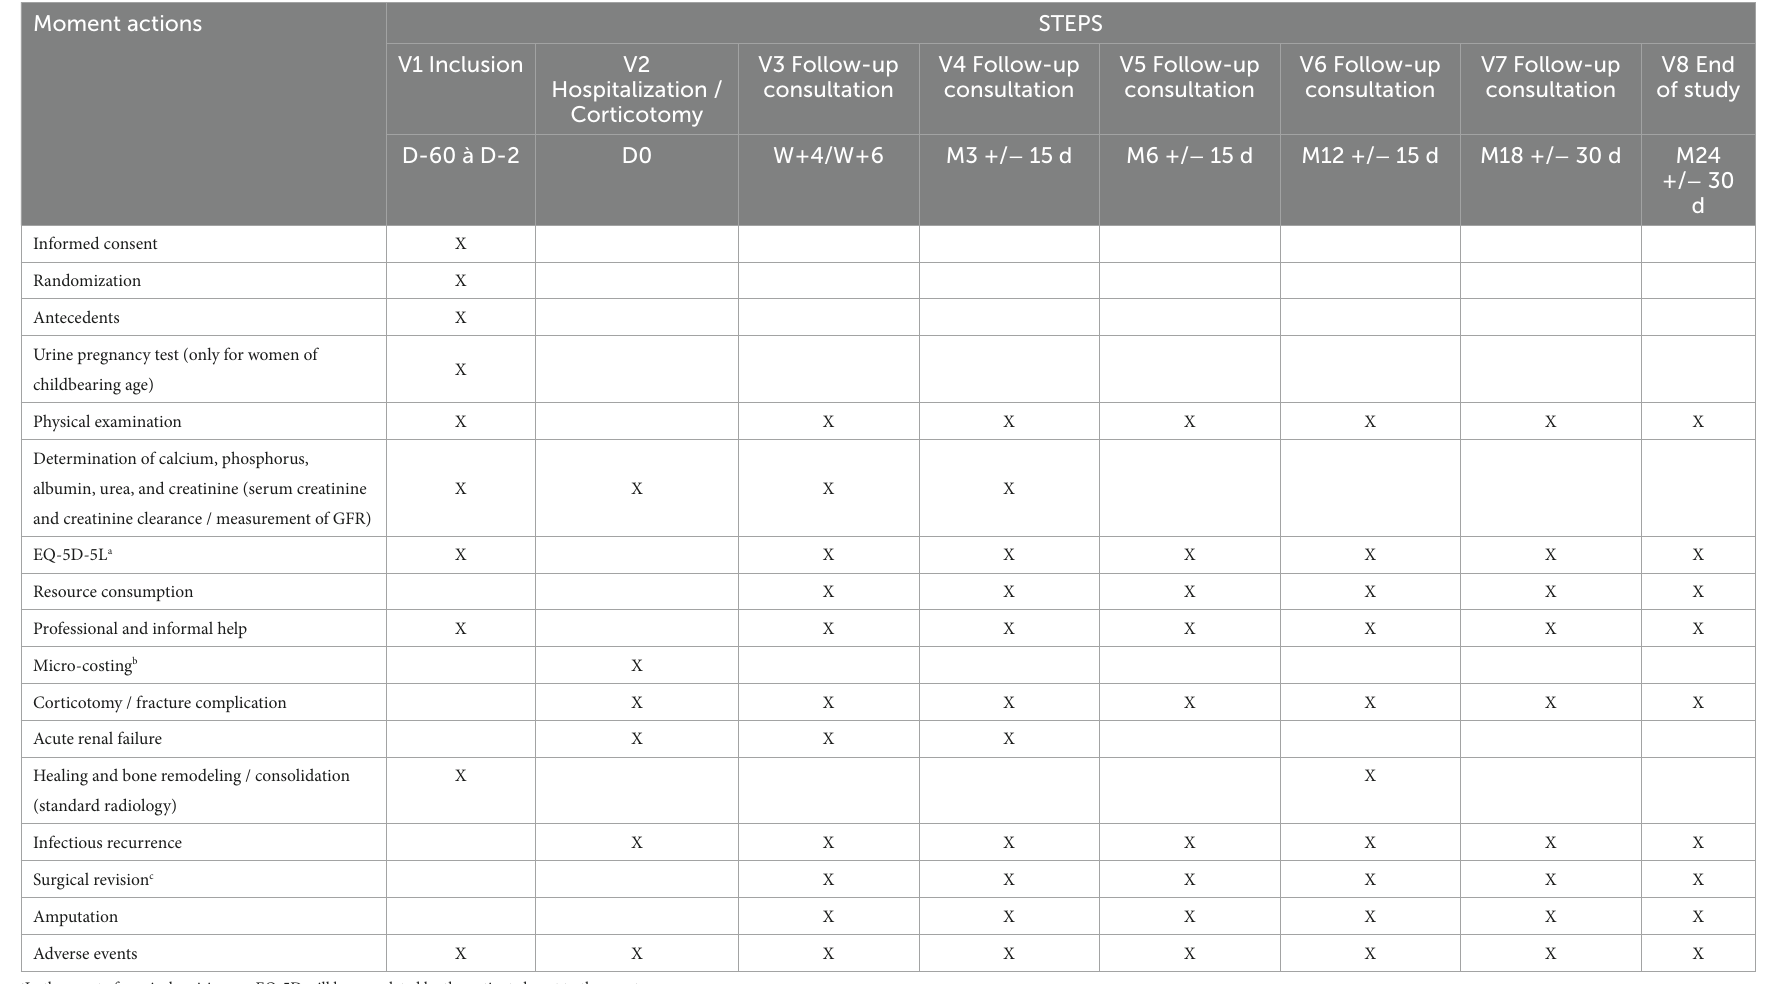
TABLE 1 Schedule for enrolment, interventions and assessments. Moment